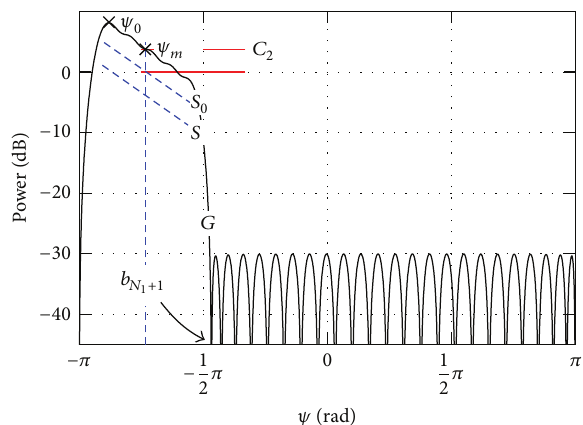
Figure20:Shaping 𝐺 ( 4 thiteration)to 𝑆 𝑟𝑥 (0 ∘ ,𝜃) relativetotheMRA instead of 𝜓 0 .